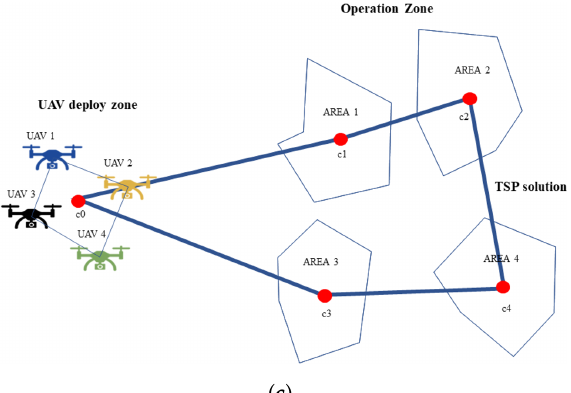
Figure 5. A schematic of the TSP applied to the multi-UAV system. ( a ) Initial problem statement. ( b ) Centroids calculation in UAV locations and multiple regions. ( c ) TSP solution found in centroids.